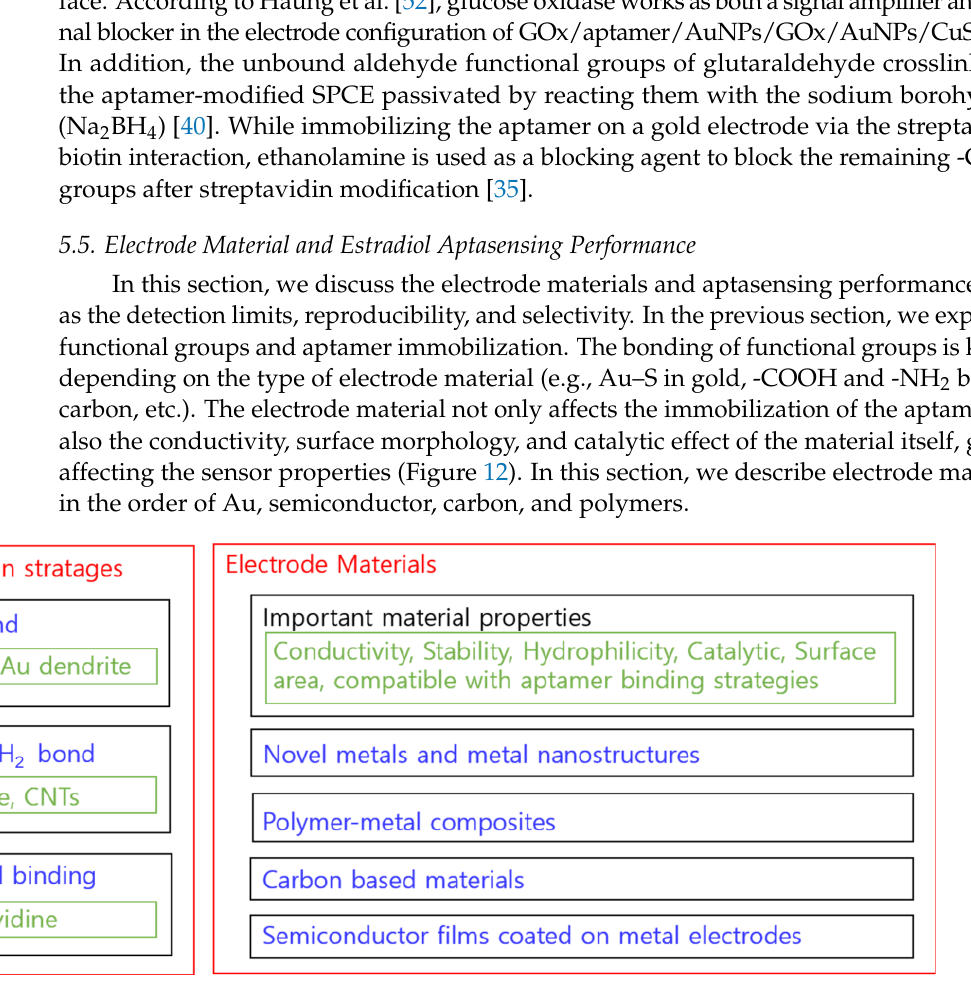
Figure 12. Immobilization strategies and electrode materials.